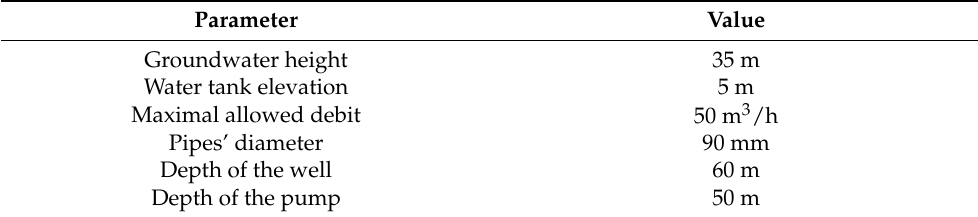
Table 2. Parameters of the hydraulic configuration of the irrigation system.